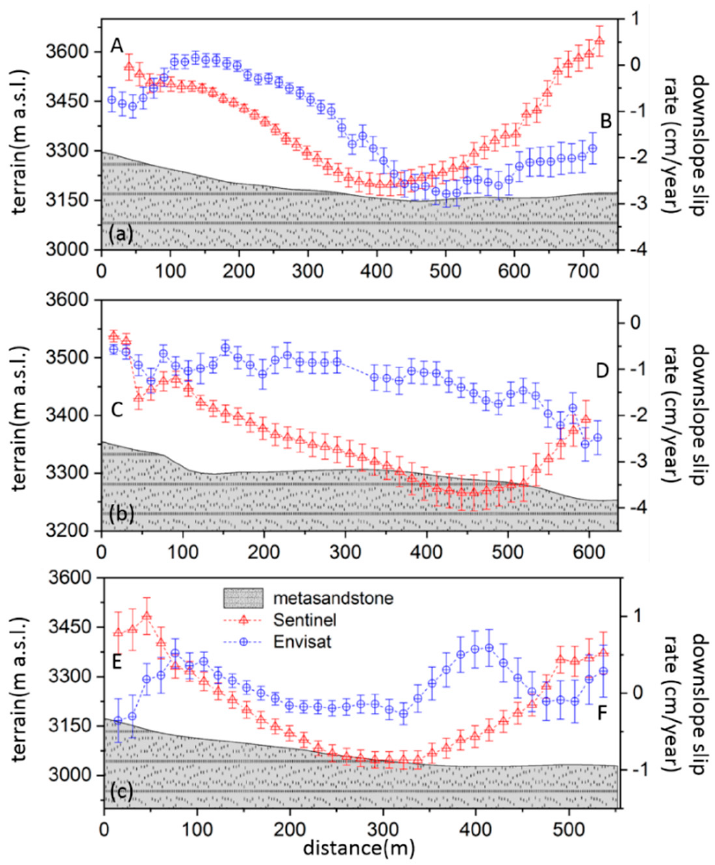
Figure 4. The cross-sections of downslope deformation rate and the landslide elevation. The locations of ( a ) cross-section AB, ( b ) cross-section CD and ( c ) cross-section EF are shown in Figure 3e. The red triangle and blue circle represent the result from the Sentinel-1 (9 October 2014–19 June 2017) and Envisat (16 June 2008–26 July 2010), respectively.